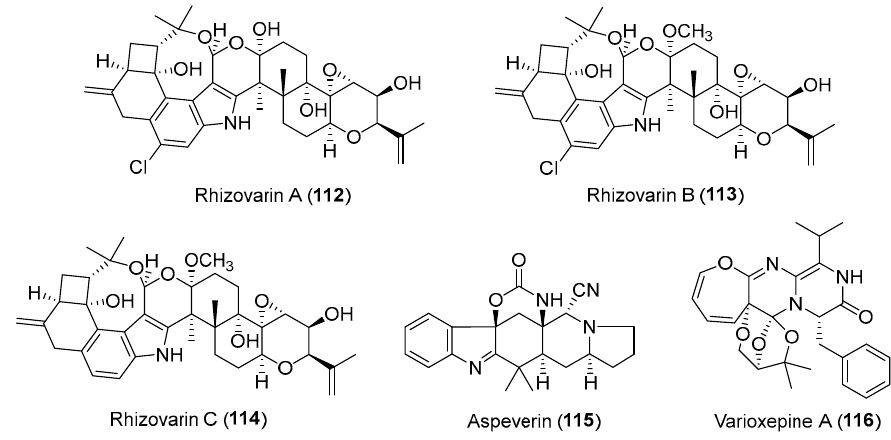
Figure 19. Structures of compounds 112 – 116 .